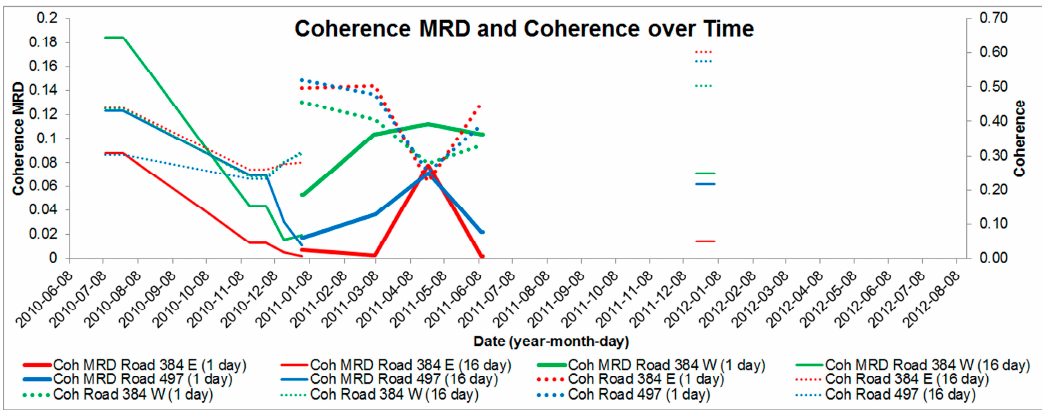
Figure 39. Graph showing clarity (contrast) of the archaeological residues in Prenestina: eastern part of Road 384 in red, western part of Road 384 in green and Road 497 in blue. Residues in the filtered σ 0 images are shown as dotted lines, in the 16-day coherence images as continuous lines, and in the 1-day coherence images as bold continuous lines. The clarity of residues is quantified as a ratio (MRD). PSMD and PSMS plotted as a grey dashed line. Negative values correspond to high PSMD (dry conditions), while positive values correspond to high PSMS (wet conditions).